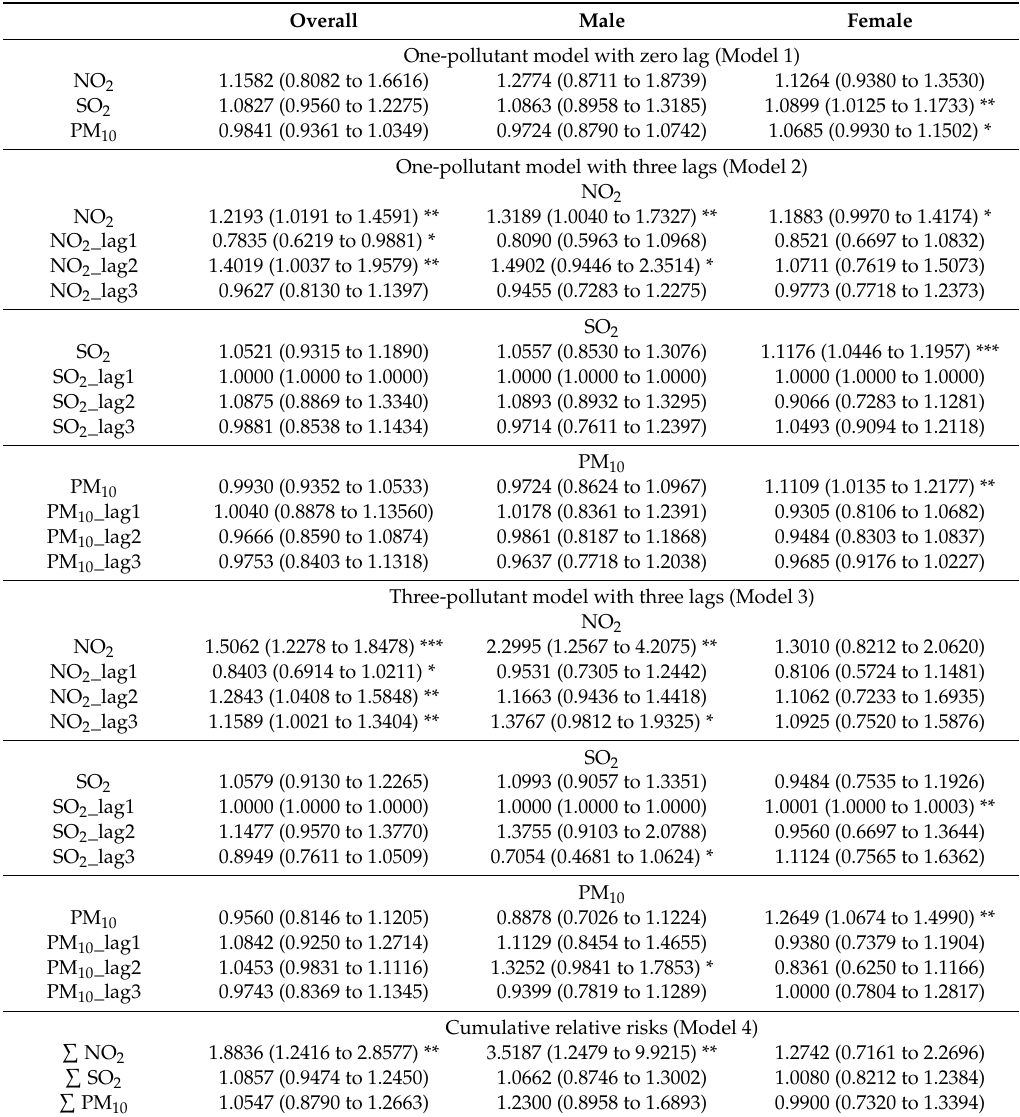
Table 4. Risks (95% CIs) of NPC incidence associated with a 10 µ g / m 3 increase in ambient NO 2 , SO 2 , or PM 10